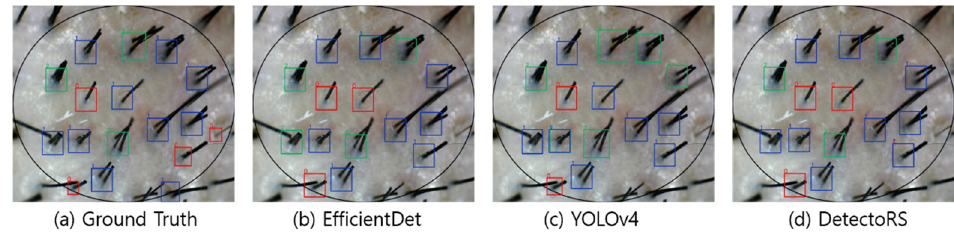
Figure 4. Visualization of detection results in a short hair image.